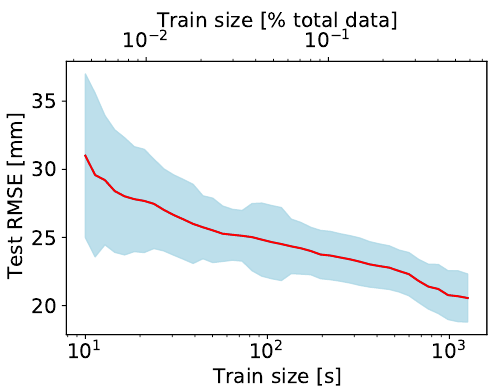
Figure 8. Dependence of the test error on the train set size. Subject S1, linear model. Note the logarithmic scale for the x -axis. Shaded regions correspond to one standard deviation about the central